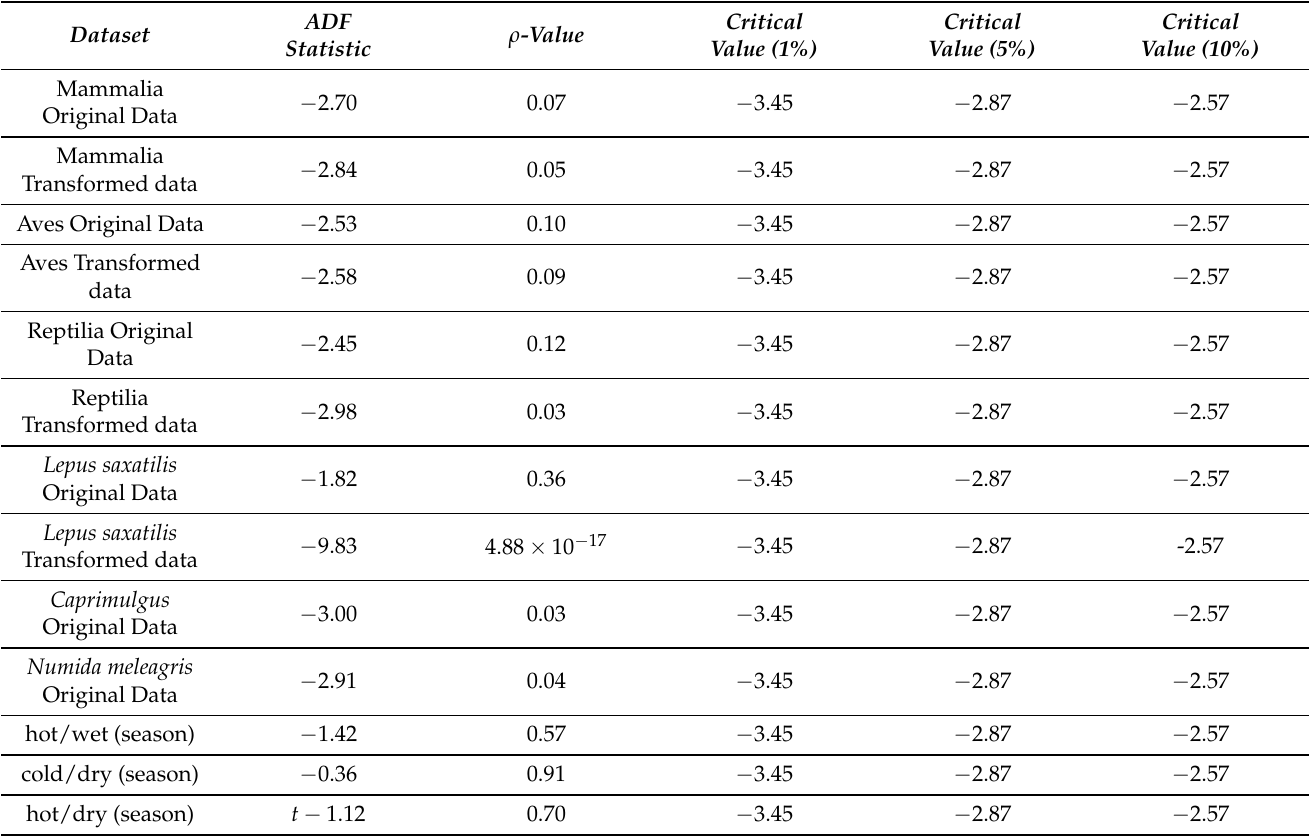
Table 3. Testing for stationarity in the datasets using ADF: results from the original and transformed series. Mammalia transformed data, Caprimulgus original data, and Numida meleagris original data show all the endogenous or dependent variables that are stationary with a critical value of 5% before or after differencing, Aves transformed data shows the endogenous variable that is stationary with a critical value of 10% even after differencing, Lepus saxatilis Transformed data shows the endogenous variable that is stationary with a critical value of 1% even after differencing, and the remaining series shows the non-stationary endogenous and exogenous series. The variables hot/wet, cold/dry, and hot/dry are the ecological seasons. These exogenous variables failed to become stationary even after differencing for all